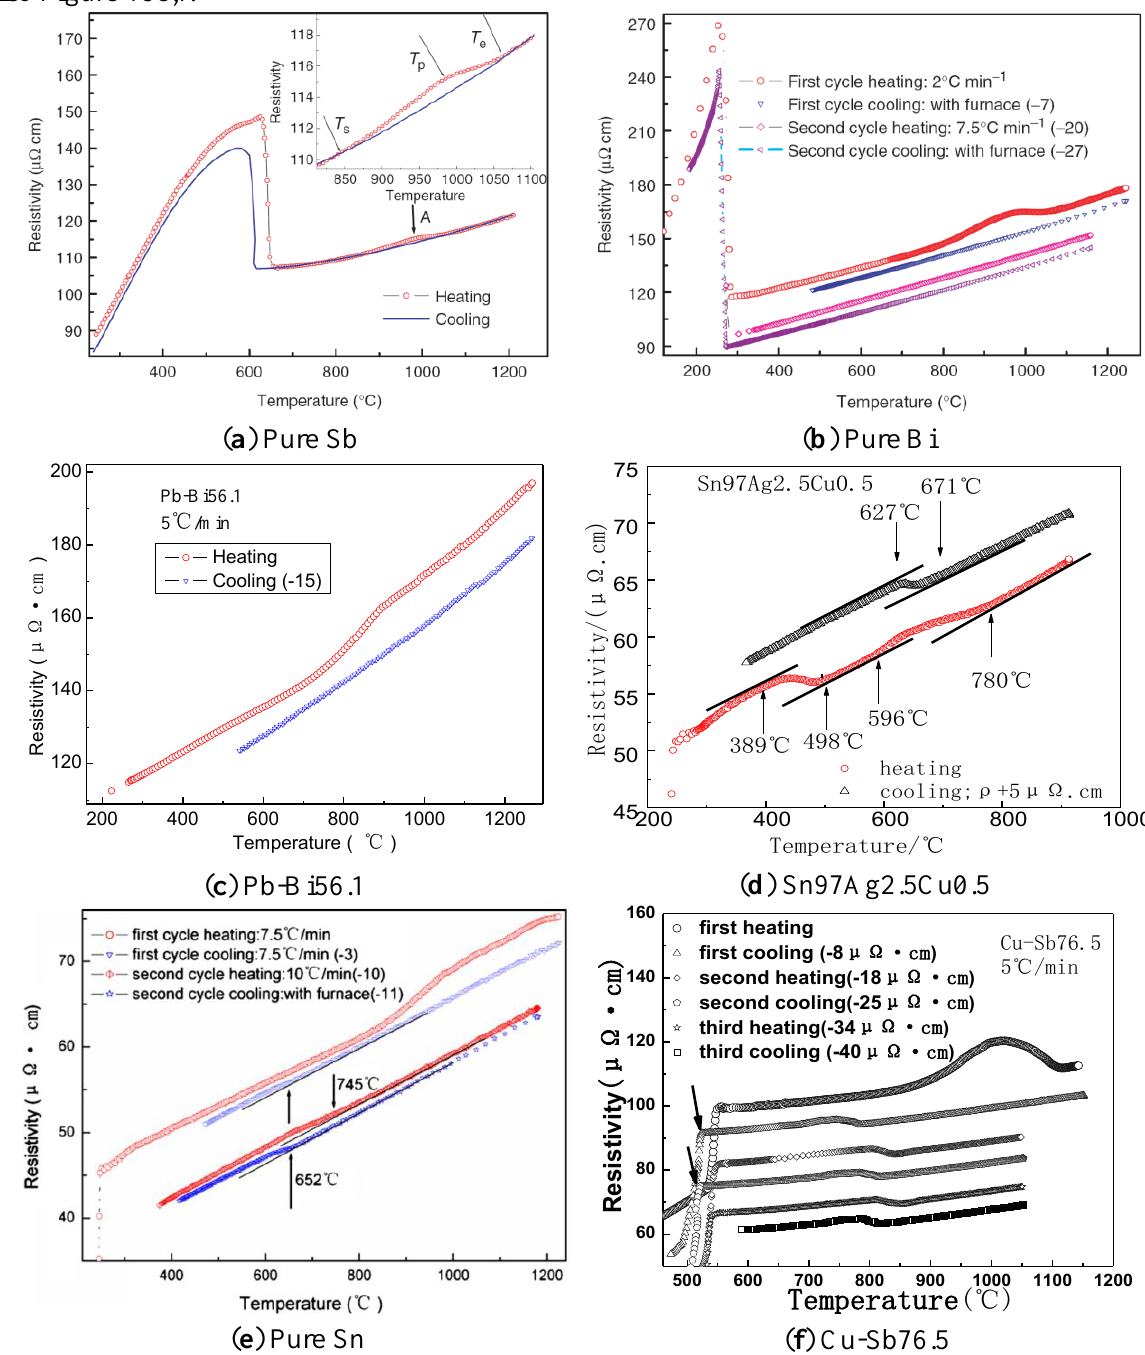
Figure 13. Is the TI-LLST reversible? Different behaviors of ρ- T in the first and further heating and cooling